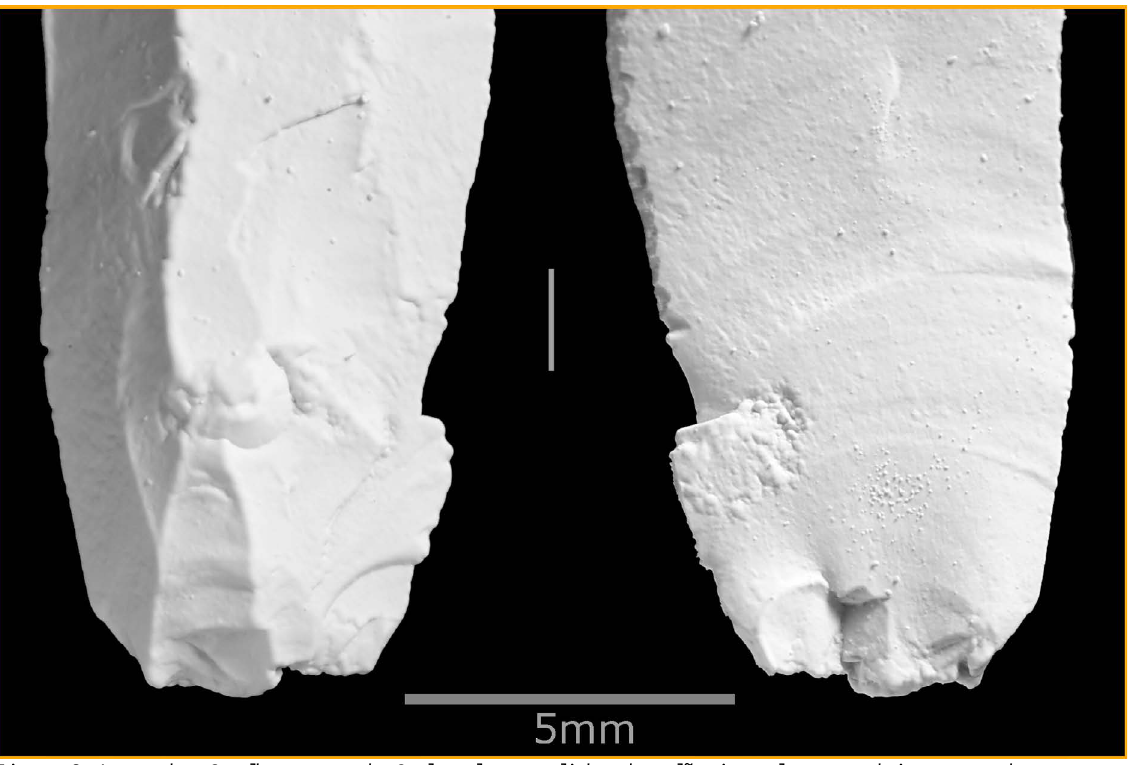
Figura 8. Lapa dos Coelhos, camada 3: lamela com linha do talão irregular com dois pontos de contacto, evidenciados por pulverização com óxido de magnésio (Foto de J. P. Ruas). Figure 8. Lapa dos Coelhos, layer 3: bladelet presenting a crack or irregular line butt and double contact points evidenced by covering with magnesium oxide (Photo by J. P. Journal of Lithic Studies (2017) vol. 4, nr. 2, p. 57-77 doi:10.2218/jls.v4i2.2532